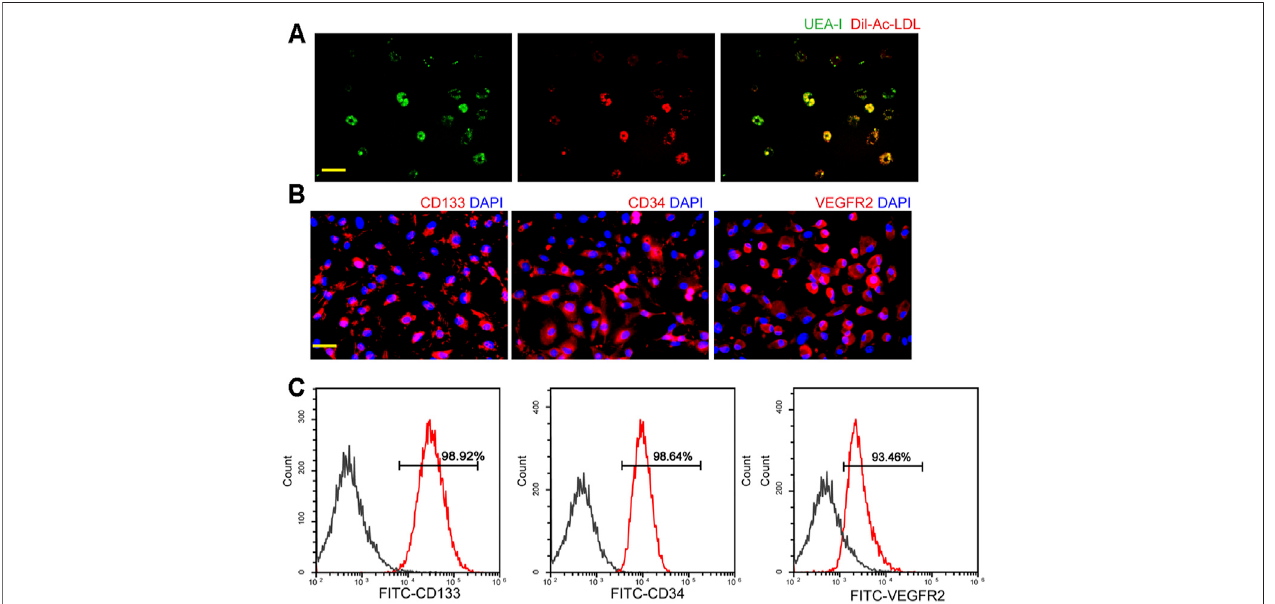
FIGURE 1 | Characterization of endothelial progenitor cells (EPCs). (A) Staining of Dil-conjugated acetylated low-density lipoprotein (Dil-Ac-LDL), FITC-Ulex Europaeus Agglutinin I (UEA-1), and merged images of double staining of Dil-Ac-LDL and FITC-UEA-I. Scale bar: 20 μ m. (B) Immuno fl uorescent staining demonstrated that EPCs had a positive expression of CD133, CD34, and VEGFR2. Scale bar: 20 μ m. (C) Flow cytometry analysis showed the expressions of CD133, CD34, and VEGFR2 in EPCs. All experiment was repeated three times.